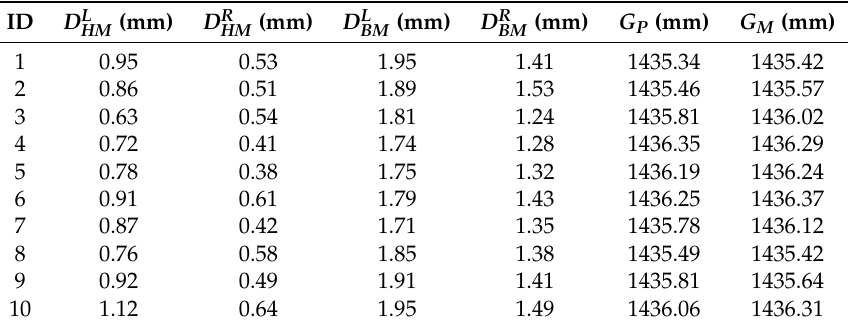
Table 1. System calibration